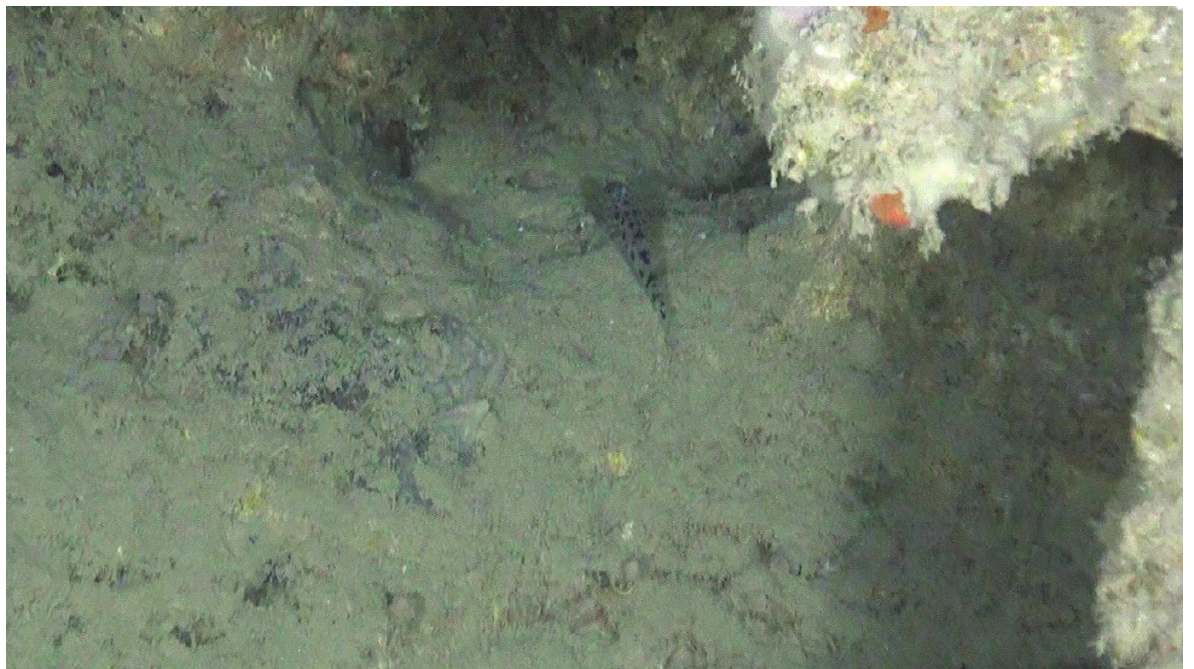
Figure 2. Image grab from ROV footage collected on 7 July 2016 at a depth of 117 m (36º00.776′N, 014º50.517′E) showing